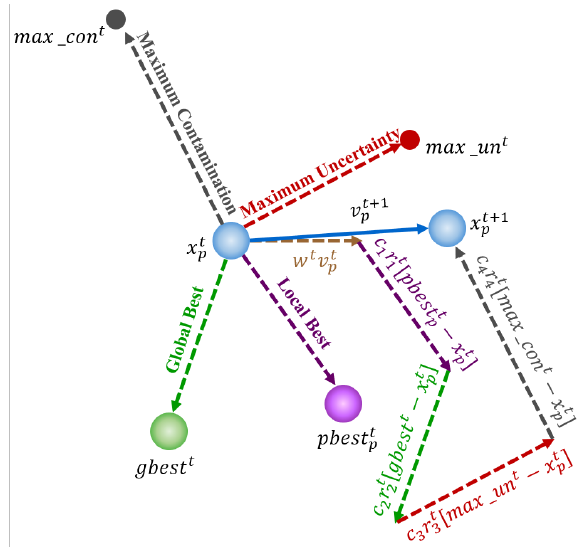
Figure 4. Components of proposed